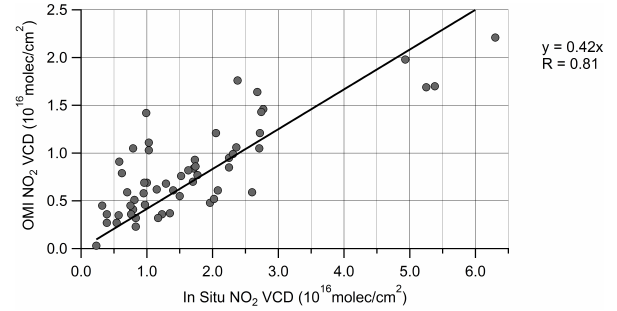
Fig. 7. Linear regression of OMI versus MAX-DOAS tropospheric NO 2